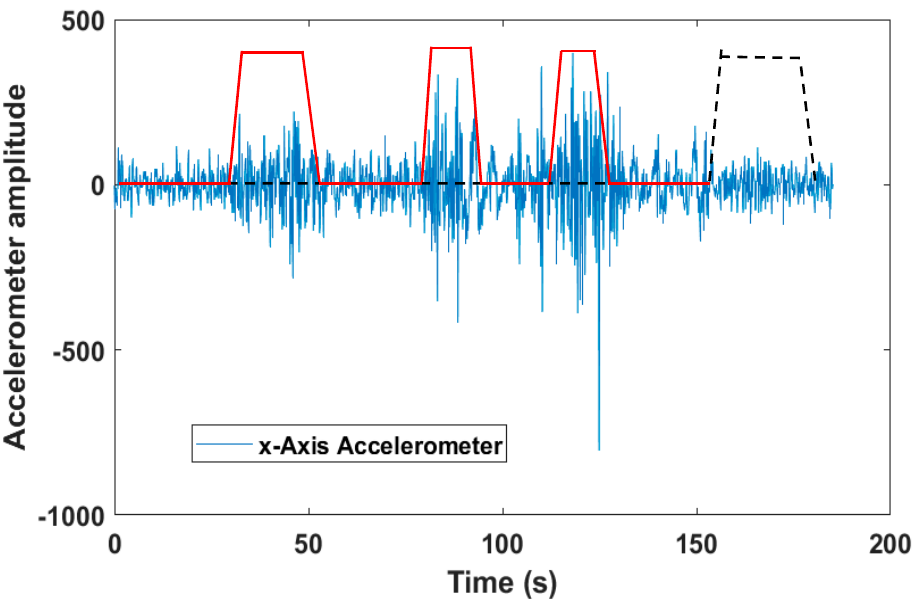
Figure 4. X-axis accelerometer trace: obstructive (red continuous line—flag) and central (black dashed line—flag) apneas.